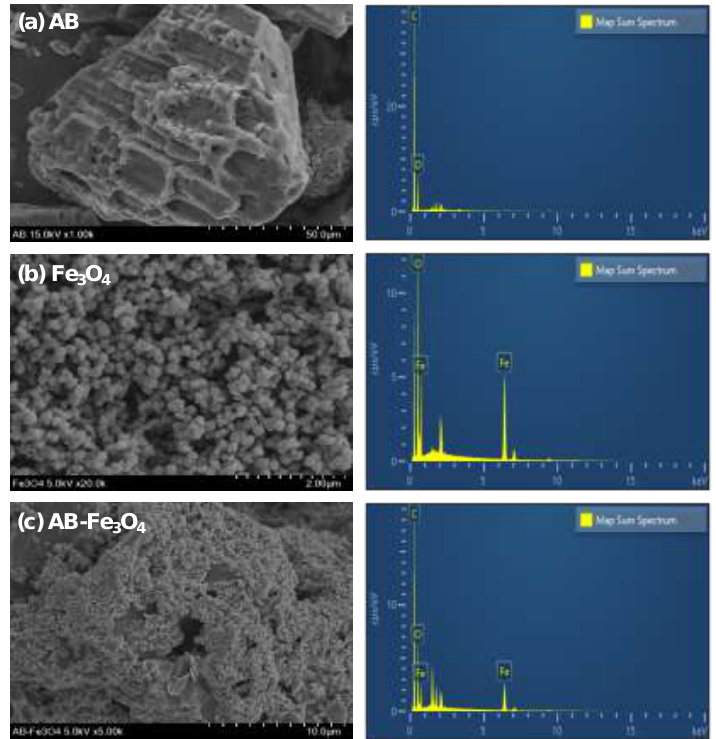
Figure 3. Representative SEM images and energy-dispersive x-ray spectroscopy (EDX) spectra of ( a ) AB, ( b ) Fe 3 O 4 , and ( c ) AB-Fe 3 O 4 .